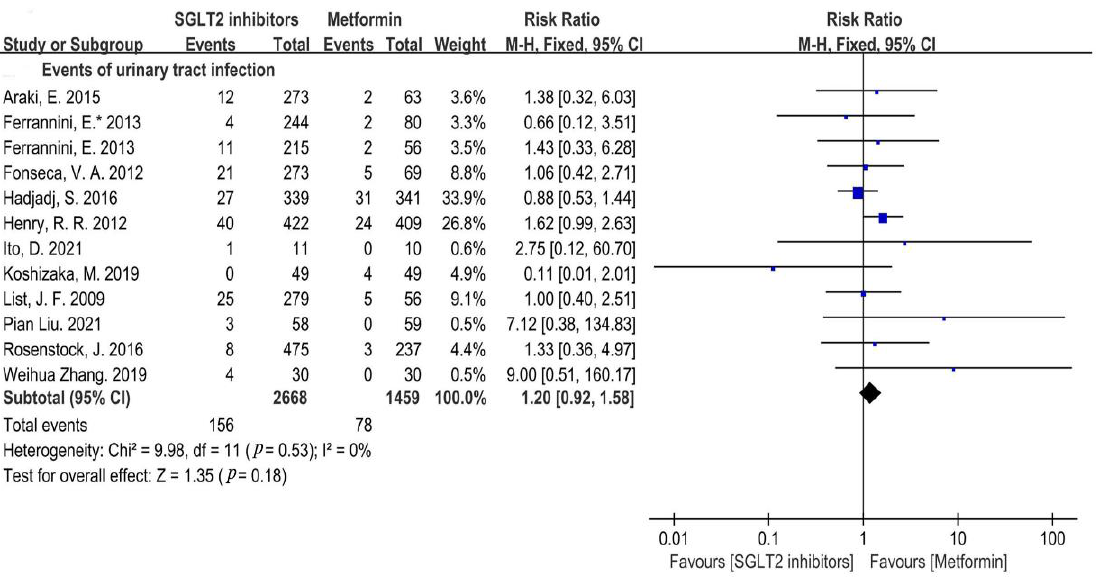
Figure 4. ( A ) Risk of genitourinary tract infections of DAPA and its different doses compared with metformin [24 – 28]. ( B ) Risk of genitourinary tract infections of EMPA and its different doses com- pared with metformin [20 – 23]. ( C ) Risk of genitourinary tract infections of CANA compared with metformin [29,30]. ( D ) Risk of genitourinary tract infections of IPRA compared with metformin [31,32]. DAPA = dapagliflozin. EMPA = empagliflozin. CANA = canagliflozin. IPRA = ipragliflozin.